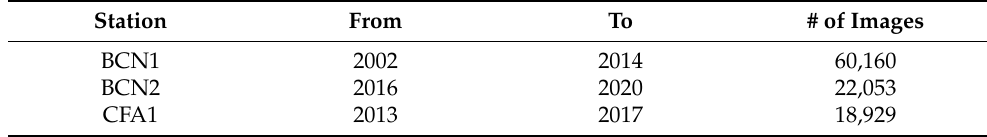
Table 5. Years analyzed and amount of images available for all three stations.